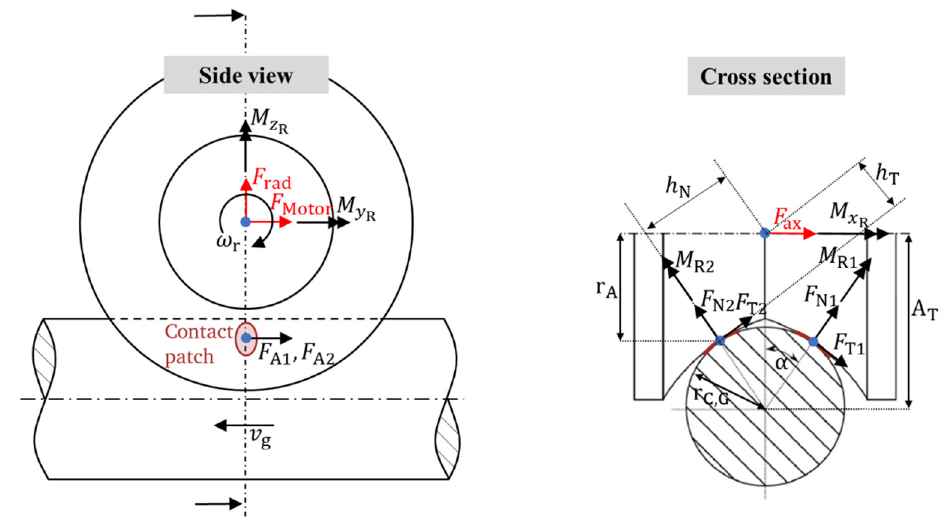
Figure 3. Forces, torques, lever arms.